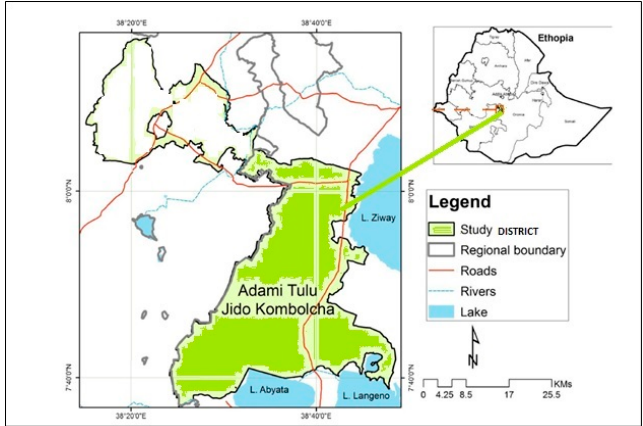
Figure 1. The physical map of the study area.